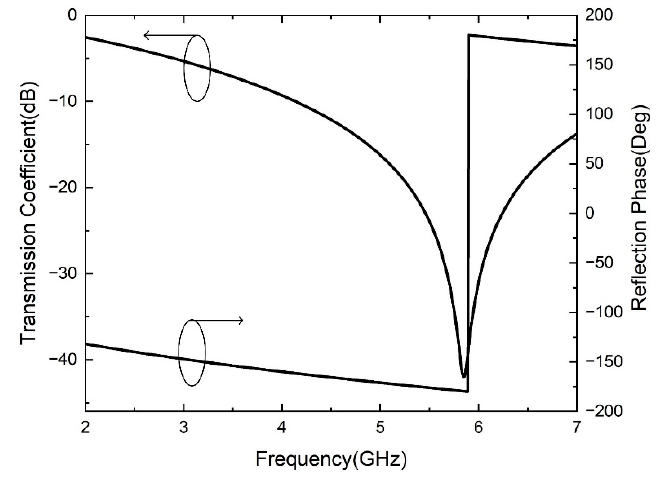
Figure 6. The simulated transmission coefficient and reflection phase of the FSS.